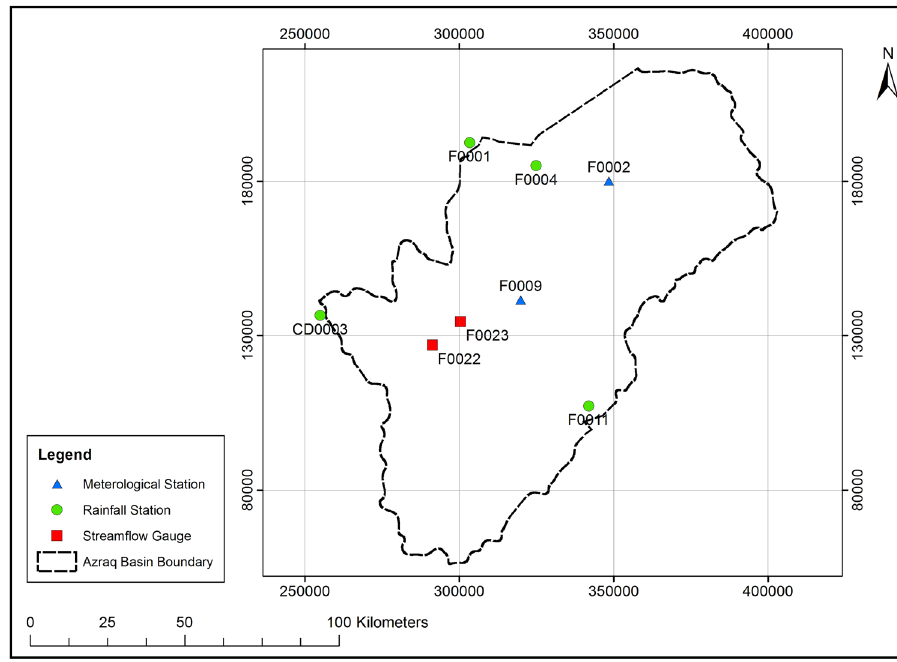
Fig. 1 Hydrological and mete- orological stations in Azraq Basin (Palestine Grid